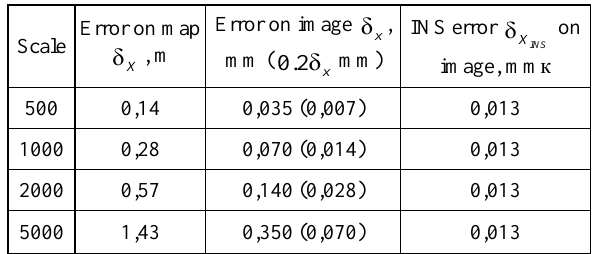
Table 2. Comparative analysis of calculated and acceptable INS errors (axis X)